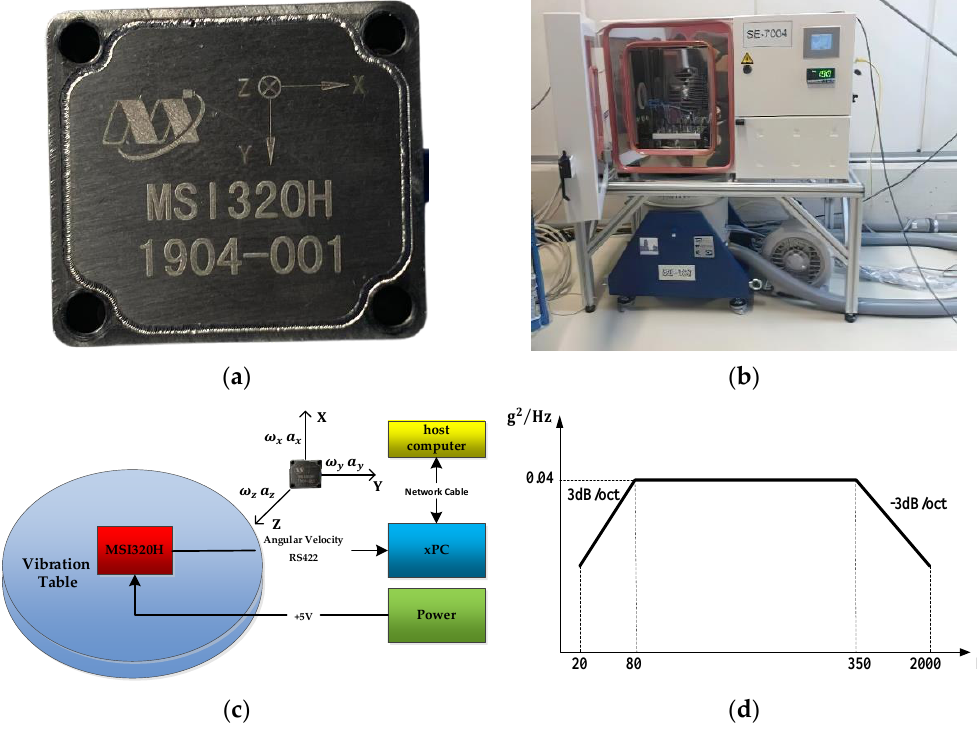
Figure 3. Experimental system. ( a ) MSI3200H inertial measurement unit, ( b ) vibration table, ( c ) data acquisition procedure, and ( d ) power spectral density of linear random vibration loads. Table 1. Specifications of MSI320H gyroscope.